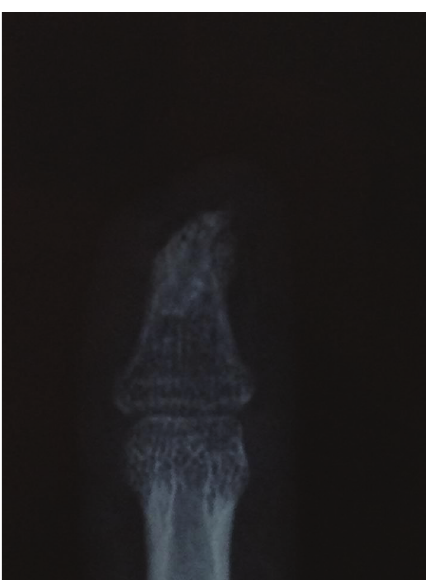
Figure 1: Erosion of the distal phalanx beneath the epithelioid